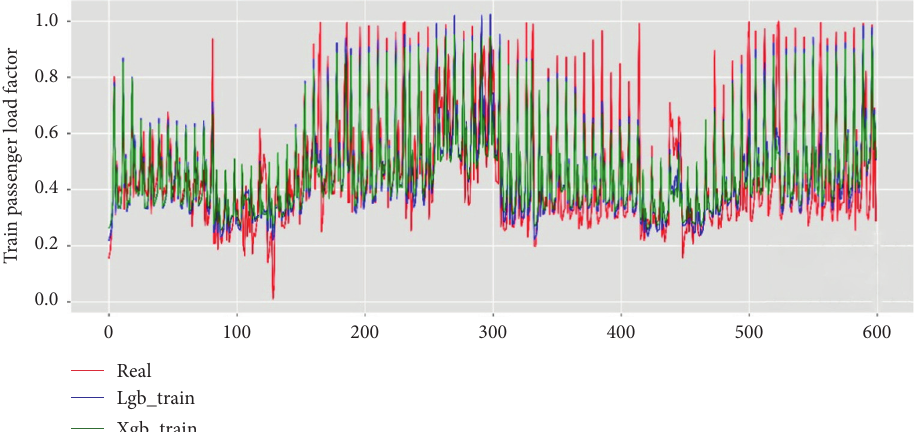
Figure 3: Comparison between LightGBM and XGBoost.